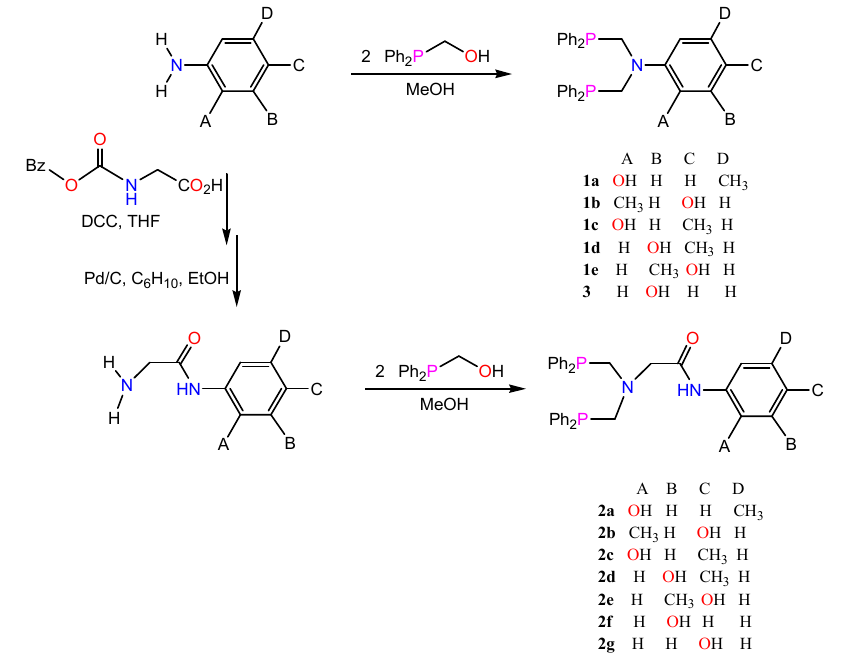
Table 1. Selected spectroscopic and analytical data for compounds 1a – 3 a